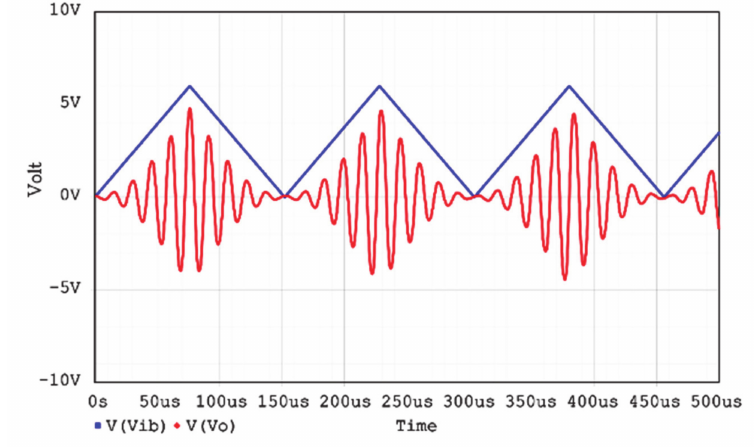
Figure 28. The simulation result of the AM signal generator using triangle wave input signal.